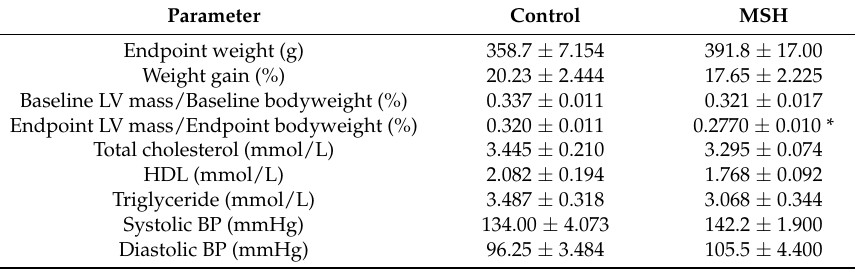
Table 1. Weight, weight gain, left ventricle (LV) mass and body weight ratio (measured by echocardiography), serum parameters and blood pressure results of untreated control ( n = 6) and alpha-MSH-treated ( n = 6) Zucker Diabetic Fatty (ZDF) rats. No significant changes were found in weight gain, plasma cholesterol and triglyceride and blood pressure values among groups. Even though decreased LV mass to body weight ratios were measured in the melanocyte stimulating hormone (MSH) group at the endpoint when compared to Control. * vs. Control, p < 0.05, Student’s t -test.